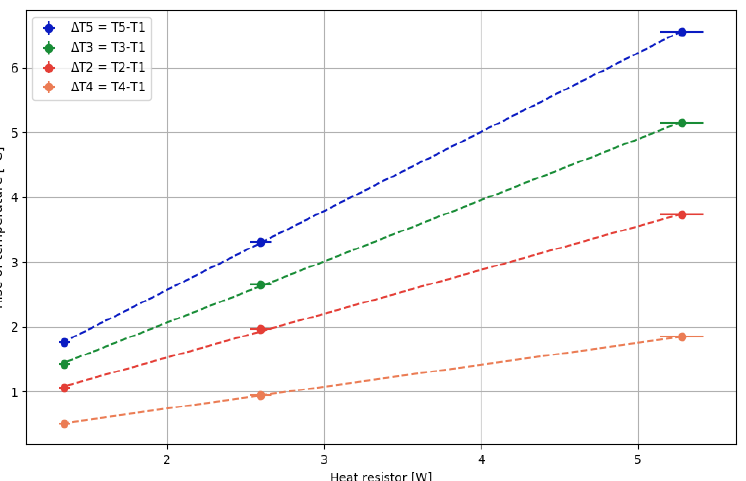
Figure 12. Measured temperature rises w.r.t. the input water temperature as a function of the power dissipated by the heater: ∆ T2 (red) is the increase in the water temperature passing through the cooling device, ∆ T5 (blue) is the difference between the temperature measured by the T5 sensor on the back of the device and the input water temperature. ∆ T4 (orange) and ∆ T3 (green) are the difference of temperature measured by the T4 and T3 sensors placed on the silicon side and the input water, respectively.